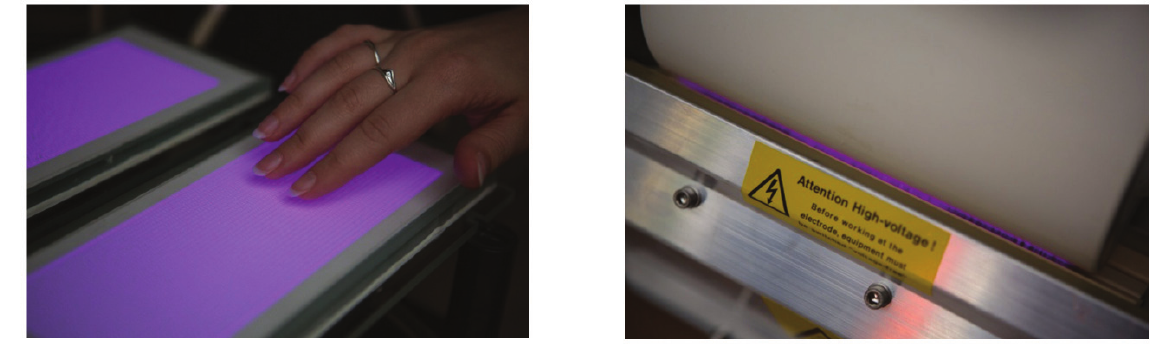
Figure 1: The photo of DCSBD electrode system on the left, the photo of industrial corona on the